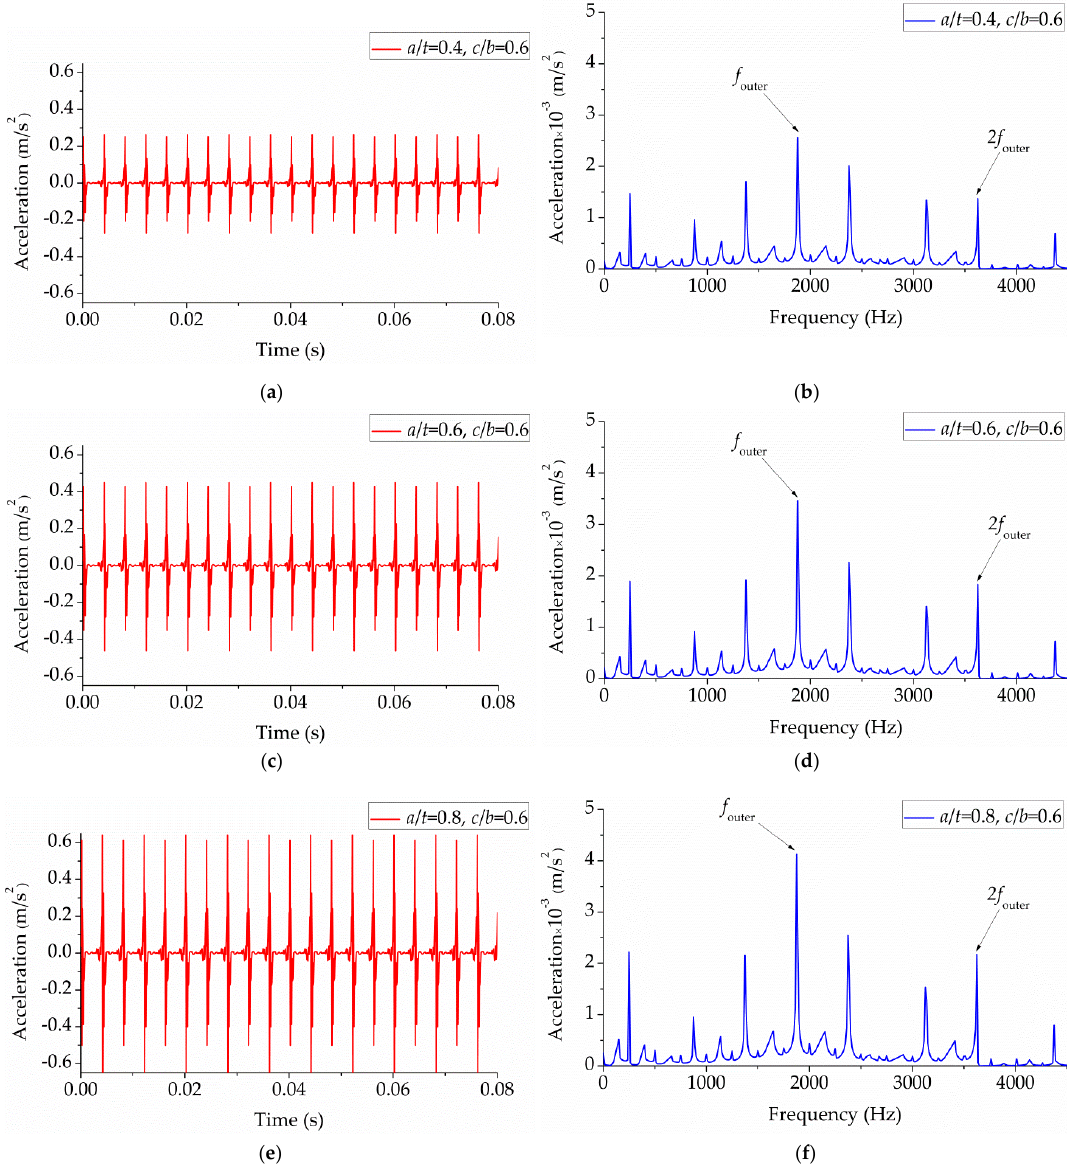
Figure 12. c / b = 0.6 time domain and frequency domain curves of vibration signals corresponding to different a / t : ( a , b ) Time-domain and frequency-domain response signals in case a / t = 0.4 c / b = 0.6; ( c,d ) time-domain and frequency-domain response signals in case a / t = 0.6 c / b = 0.6; ( e , f ) time-domain and frequency-domain response signals in case a / t = 0.8 c / b = 0.6.